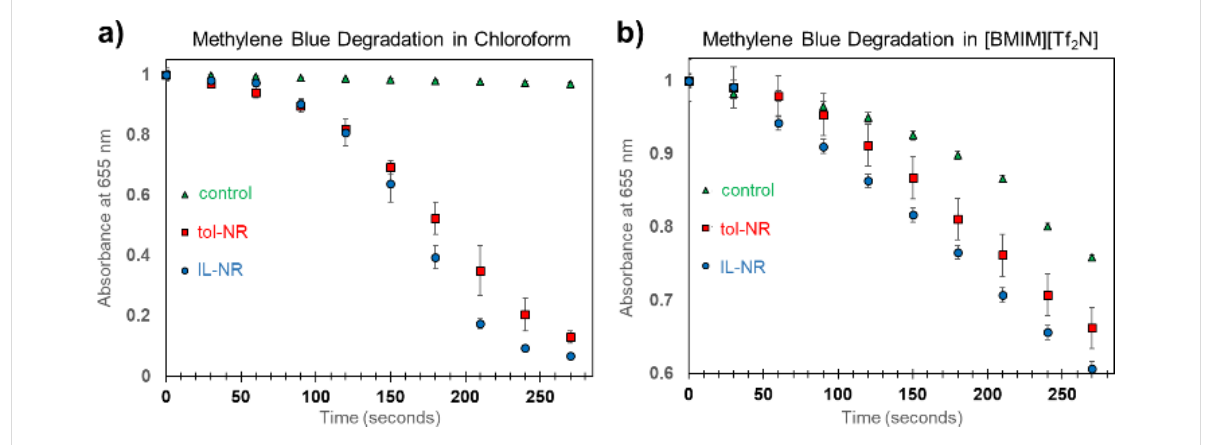
Figure 2: Comparison of photocatalytic activity for tol-NR and IL-NR. a) Dye degradation experiments conducted in chloroform. b) Dye degradation experiments conducted in [bmim][Tf 2 N]. The control in both cases shows dye degradation without a catalyst present. All data points have error bars representing the standard deviation of three trials per data